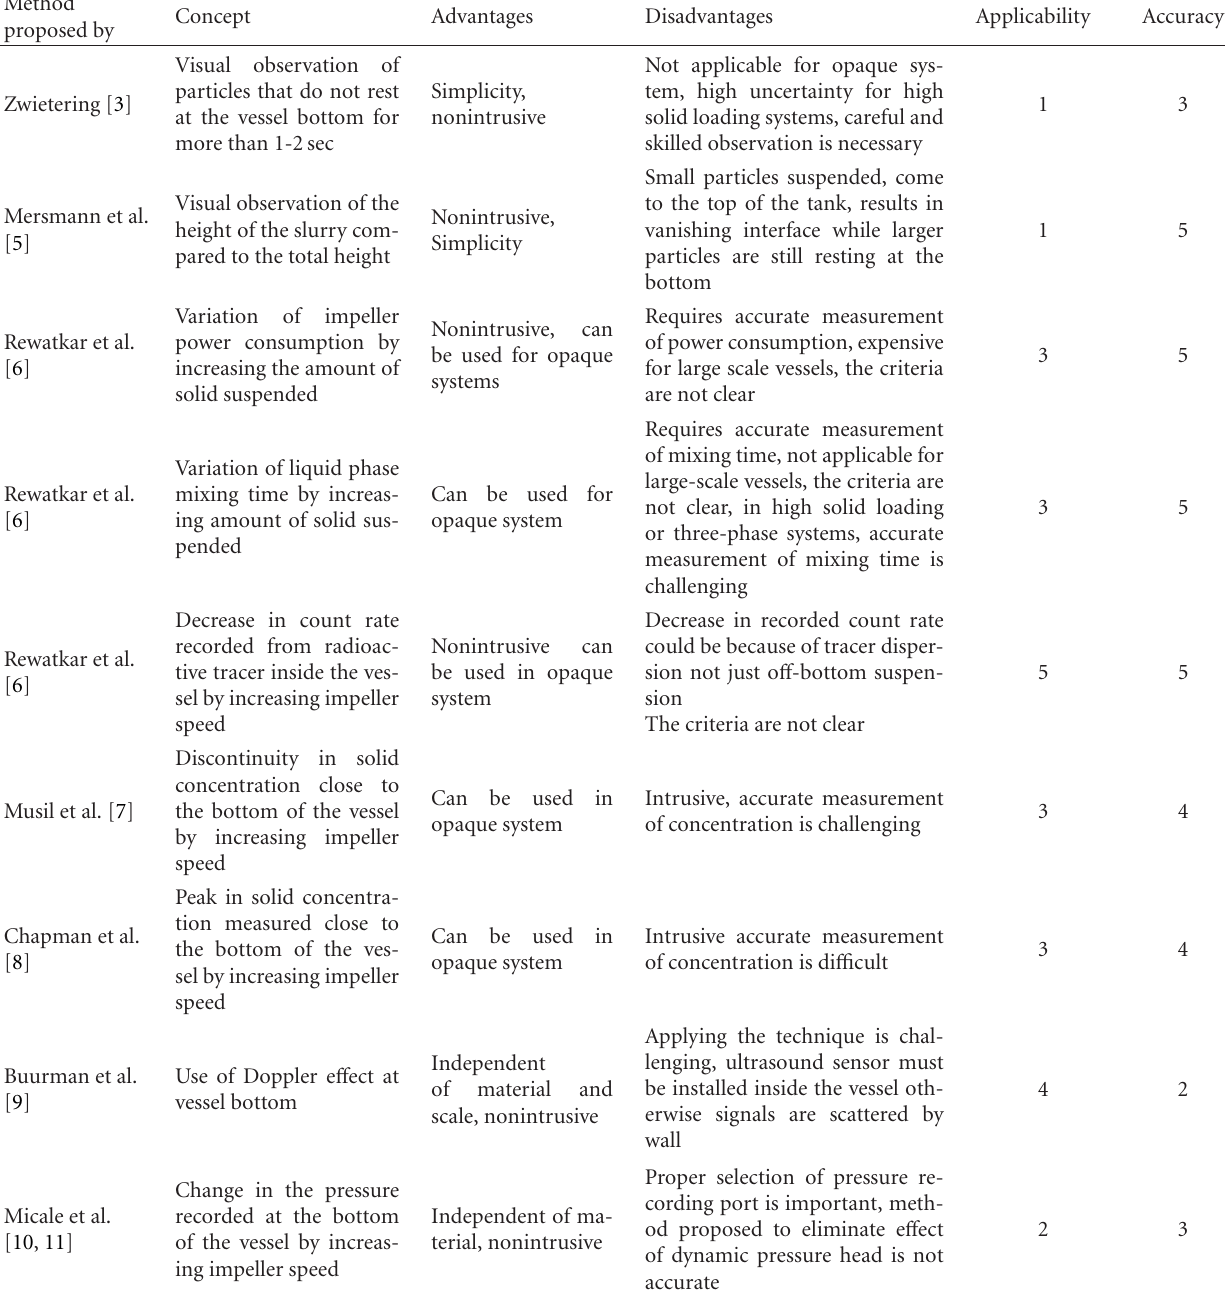
Table 1: Experimental methods for characterizing N JS (adapted from [1,